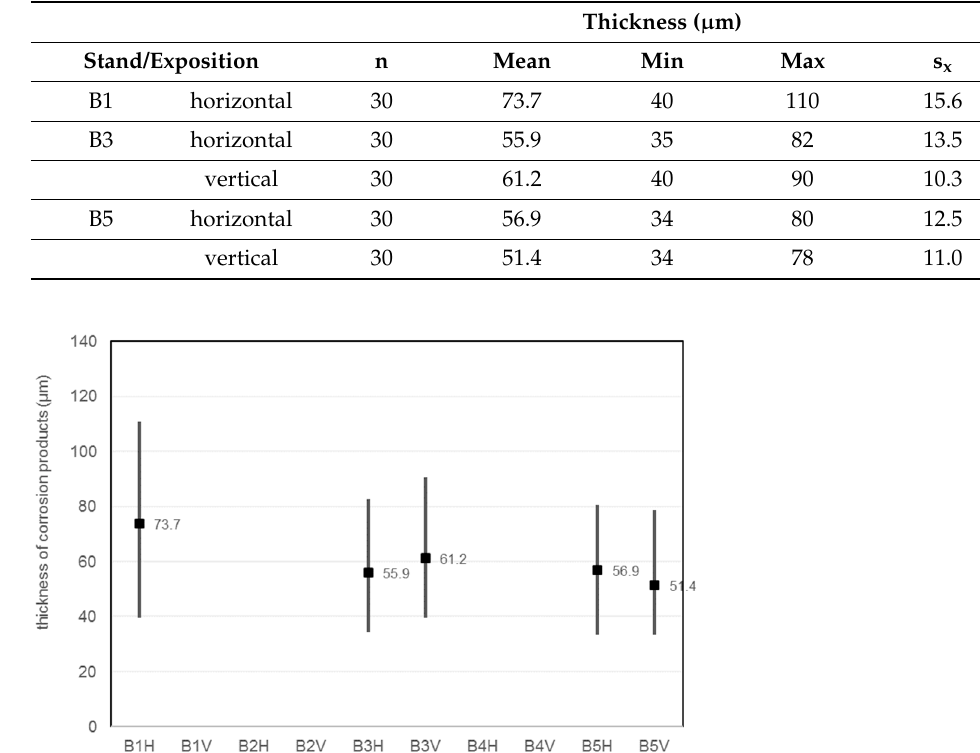
Figure 10. Thickness of corrosion products.